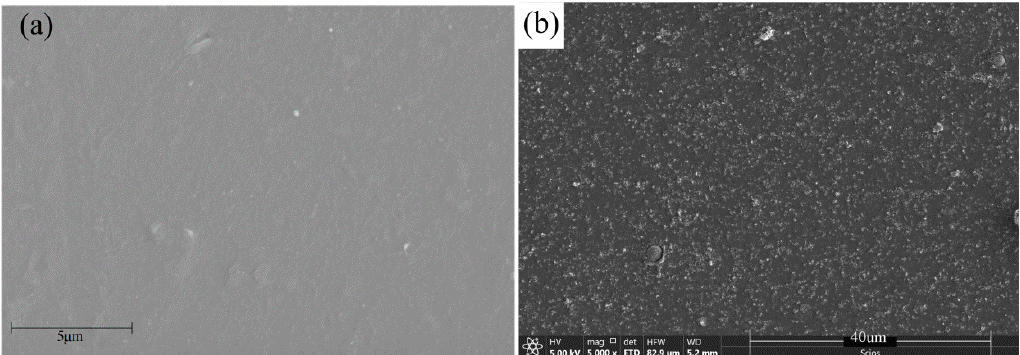
Figure 5. SEM micrographs of CB / PVDF composites (CB content 2.0 wt.%): ( a ) SEM surface micrographs; ( b ) fracture surface